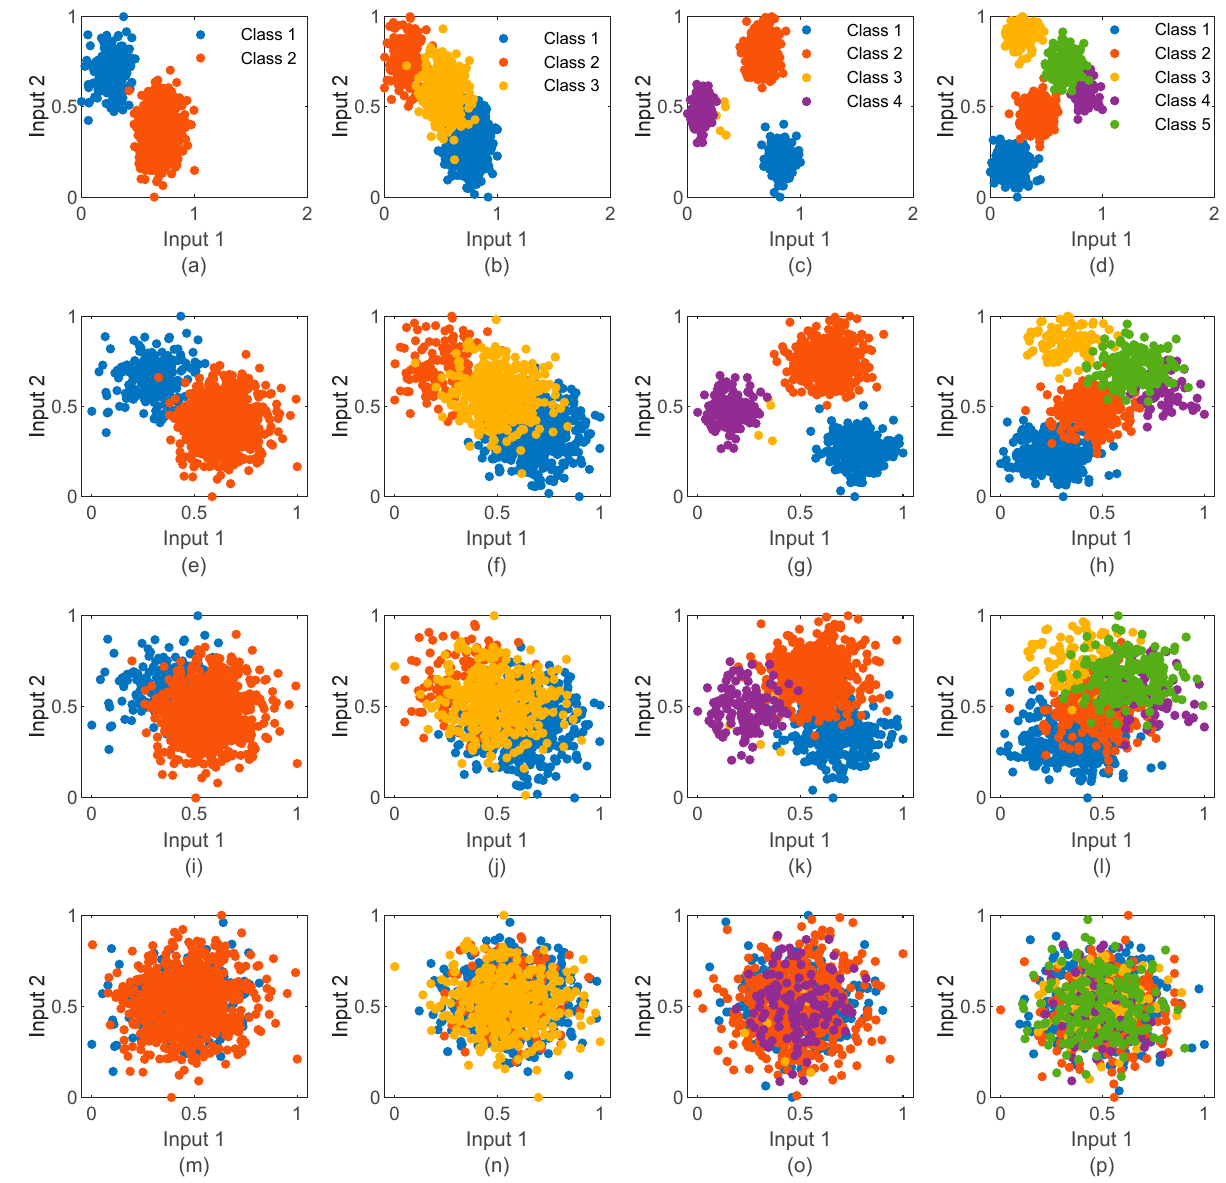
Figure 1. Illustration of dataset scatters: ( a – d ) Data scatters of S01 for C01,C02, C03, C04; ( e – h ) Data scatters of S02 for C01,C02, C03, C04; ( i – l ) Data scatters of S03 for C01,C02, C03, C04; ( m – p ) Data scatters of S04 for C01,C02, C03, C04.